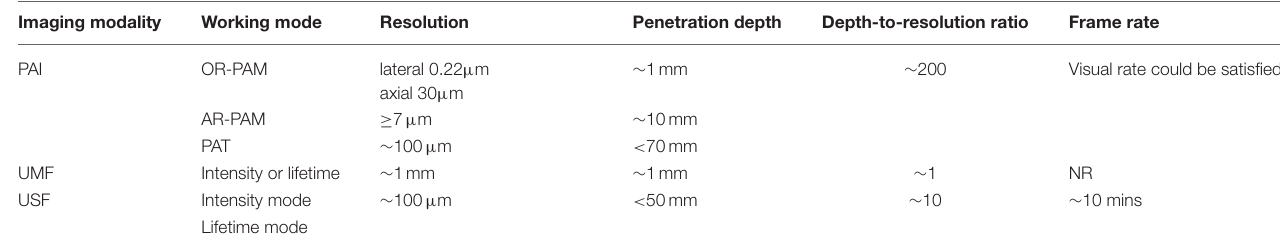
FIGURE 9 | Experiment results for the 100mm ( x ) × 40mm ( y ) × 100mm (z) agarose phantom with a single 3mm diameter target (Nouizi et al., 2015). (a) True ThermoDot distribution in the optical fiber plane. (b) Binary map obtained using TM-FT. (c) Reconstructed fluorescence map using conventional FT with no a priori information. (d) Reconstructed fluorescence map using TM-FT. The profiles across the fluorescence target along (e) x - and (f) y -directions show that the size of the fluorescence target is accurately recovered. Copyright 2015 © OSA Publishing. TABLE 3 | Comparison of selected specifications of PAI, UMF, and USF imaging systems. Imaging